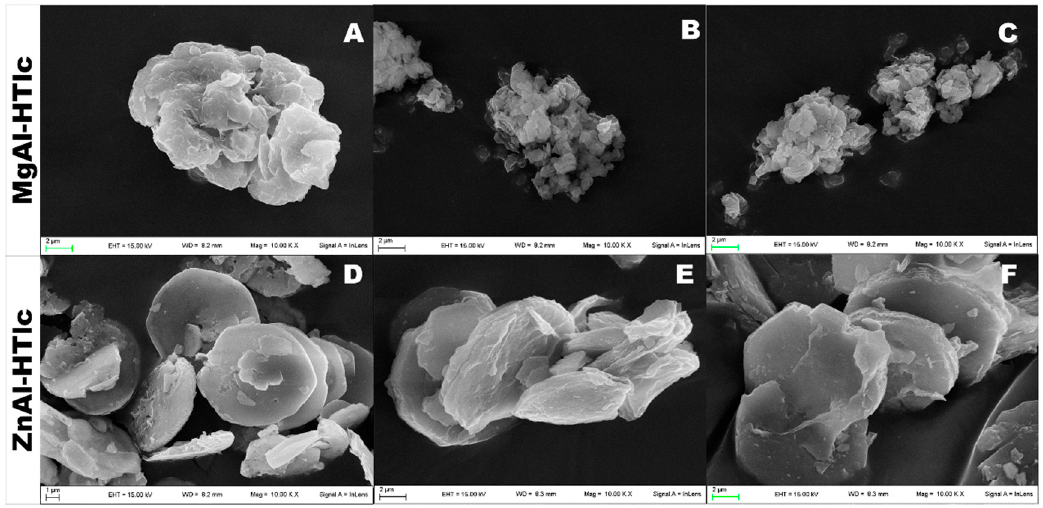
Figure 2. SEM micrographs of: ( A ) MgAl-Cl; ( B ) and ( C ) MgAl-ALA; ( D ) ZnAl-Cl; and ( E ) and ( F ) ZnAl-ALA.